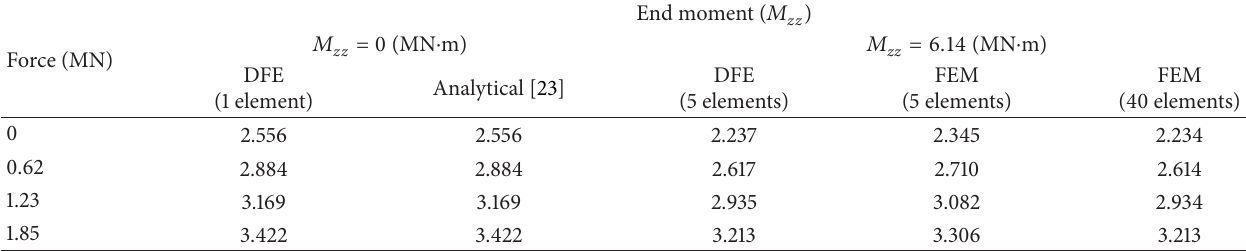
Table 1: DFE fundamental frequencies (Hz) for cantilevered (C-F) boundary condition.